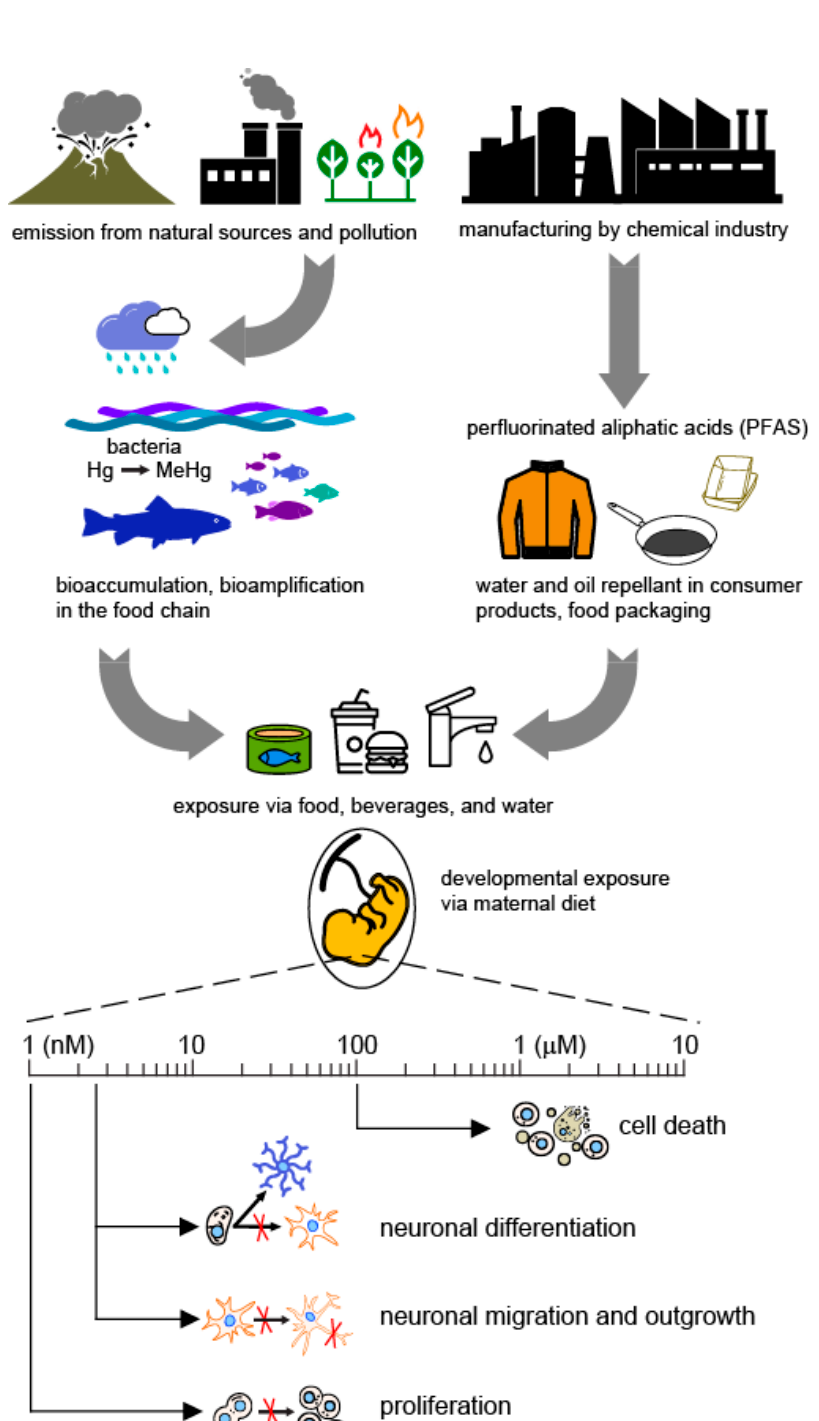
Figure 1. Overview of MeHg/PFAS exposure paths and toxic effects in NSCs. PFAS have been